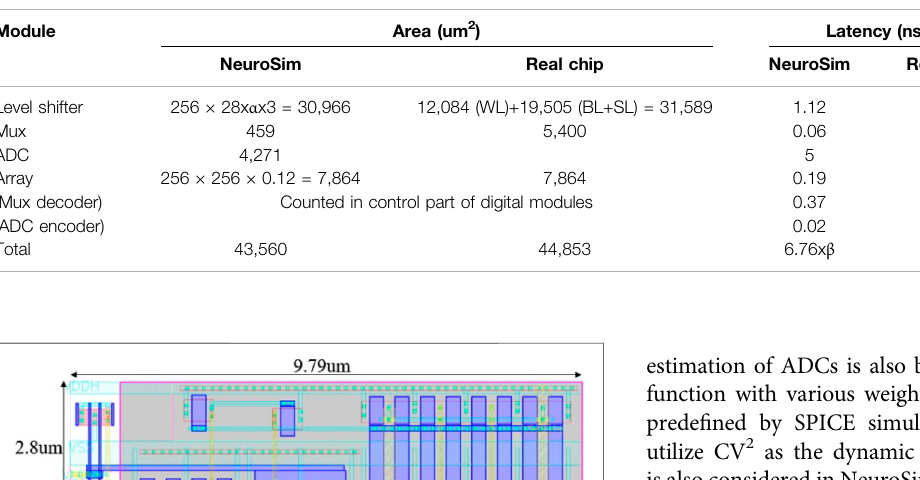
TABLE 3 | Analog module validation.